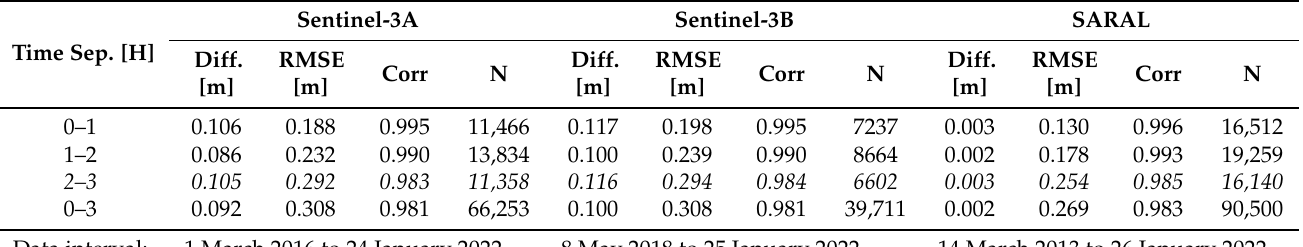
Table 1. SWH measurements from Sentinel-3A, Sentinel-3B, and SARAL compared with CryoSat-2. Here, the time separation increases by one-hour intervals up to a three-hour time separation to show the decrease in correlation and increase in root mean squared error (RMSE).